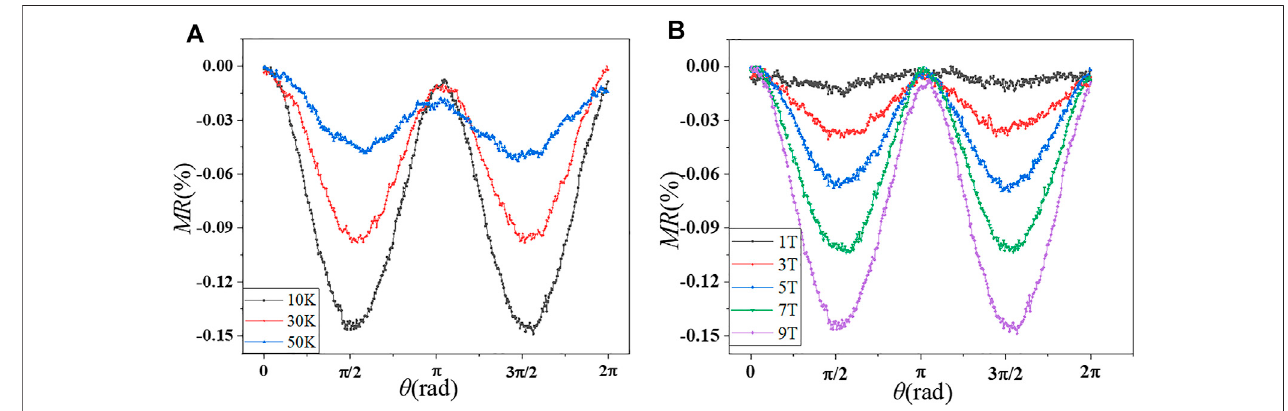
FIGURE 3 | (A) Out-of-plane AMR measured at 9 T at different temperatures. (B) Out-of-plane AMR at 10 K under different magnetic fi elds.